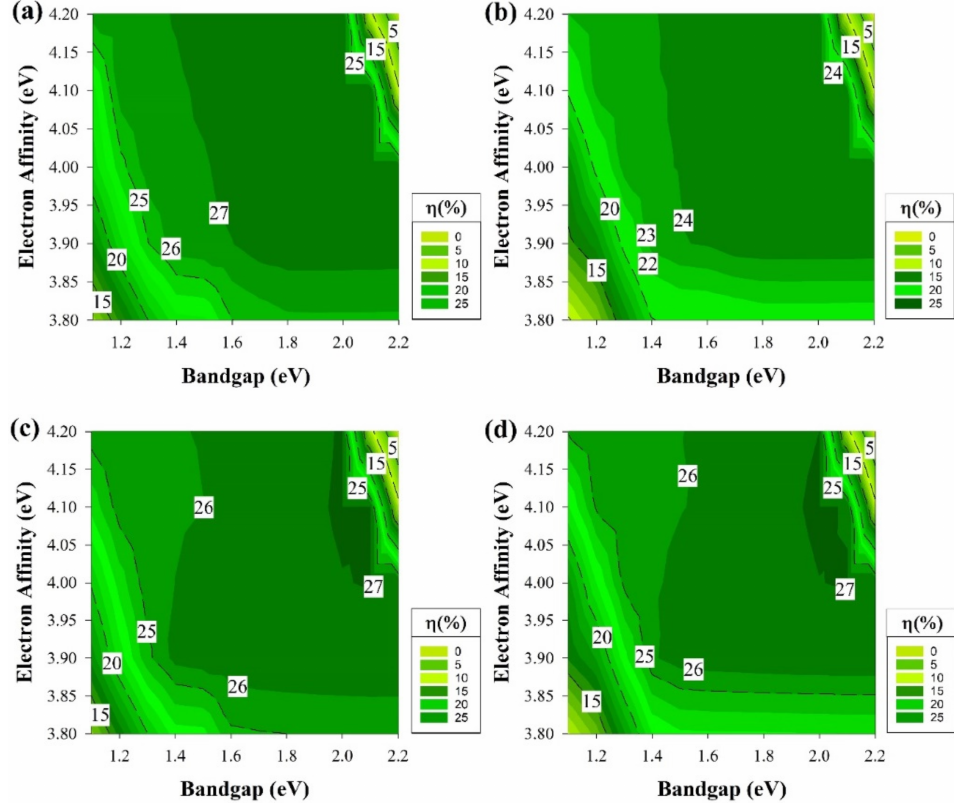
Figure 8. The efficiency of four proposed structures, including a-Si:H passivating layers as a function of E g and χ for doped layers with defects at the 0.2 eV level above E V . ( a ) Contour graphs of the n-i-p structure with p-type wafer base. ( b ) Contour graphs of the n-i-p structure with n-type wafer base. ( c ) Contour graphs of the p-i-n structure with the p-type wafer. ( d ) Contour graphs of the